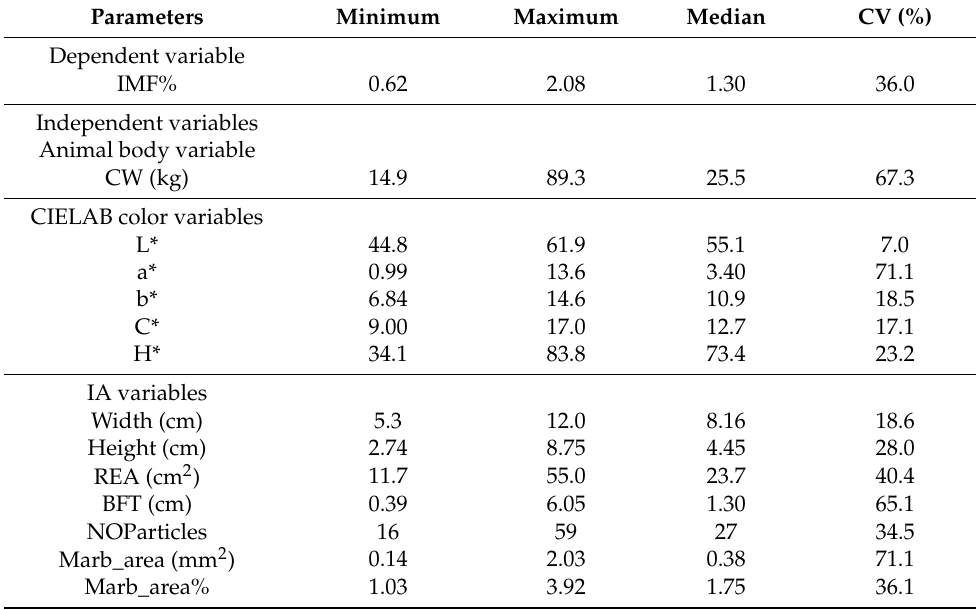
Table 1. Global results for all variables considered in this